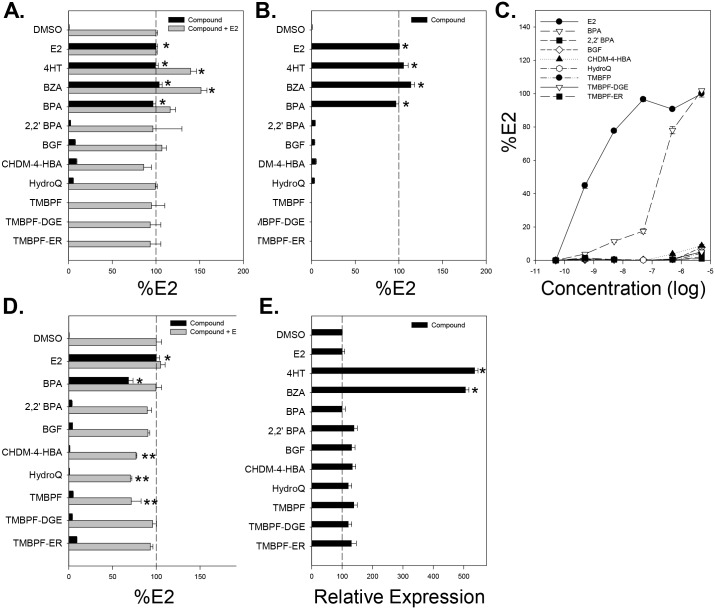
PRL-HeLa analysis of ERβ estrogenic and anti-estrogenic activity of investigational chemical compounds.Percentage of cells with an array in GFP-ERβ:PRL-HeLa cells after 1 hour of treatment with maximal dose of compound alone or with 10 nM E2 after 1 hour (A) or 24 hours (B) of exposure. (C) Dose-response curves of percent of cells with arrays for E2, BPA and the seven investigational compounds (D) Effects on GFP-ERβ expression level after 24 hours of treatment with maximal dose of compound. All data represent mean of a minimum of 4 experiments ± standard deviation. (*) or (**) indicates a response signifcantly (p < 0.05) above or below control treatment.